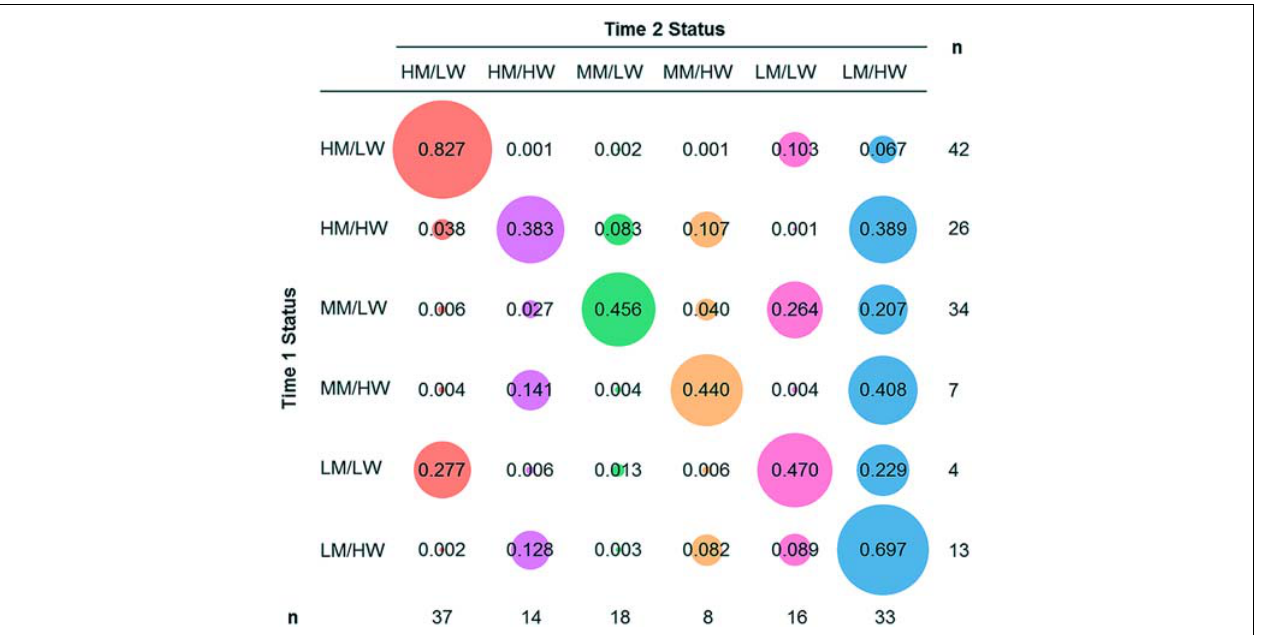
status fromTime 1 toTime 2. All other probabilities (i.e., not on the left-to-right diagonal) are indicate probabilities of individuals change statuses fromTime 1 toTime 2. Statuses are HM/LW (highWM/low worry), HM/HW (highWM/high worry), MM/LW (moderateWM/low worry), MM/HW (moderateWM/high worry), LM/LW (lowWM/low worry), and LM/HW (lowWM/high